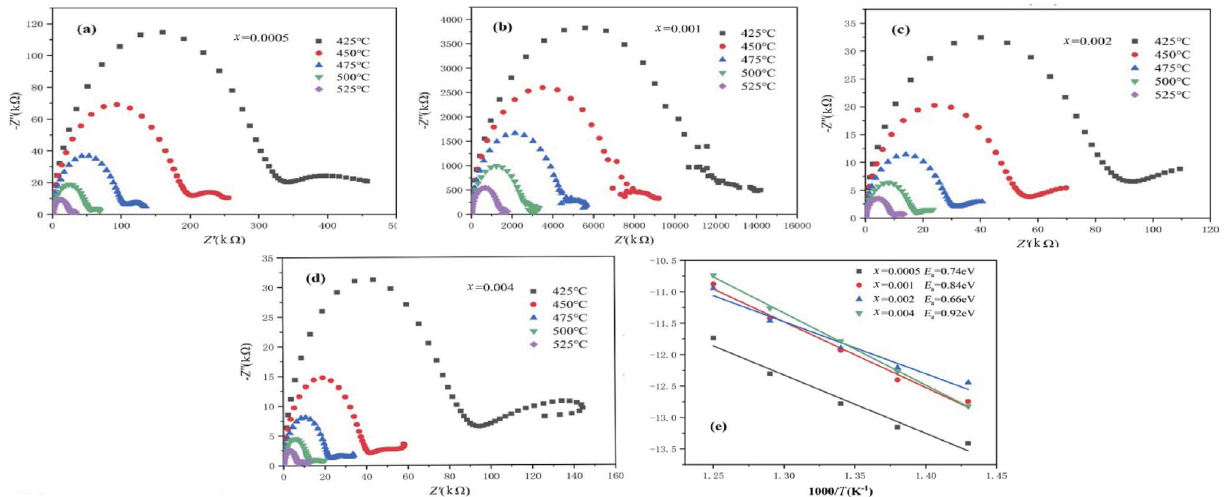
Fig. 10 Complex impedance plots for the KNNS–0.04BNKZ– x Sm ( x = 0.0005, 0.001, 0.002, and 0.004) ceramics at various temperatures and arrhenius plots of σ dc conductivity of the KNNS–0.04BNKZ– x Sm